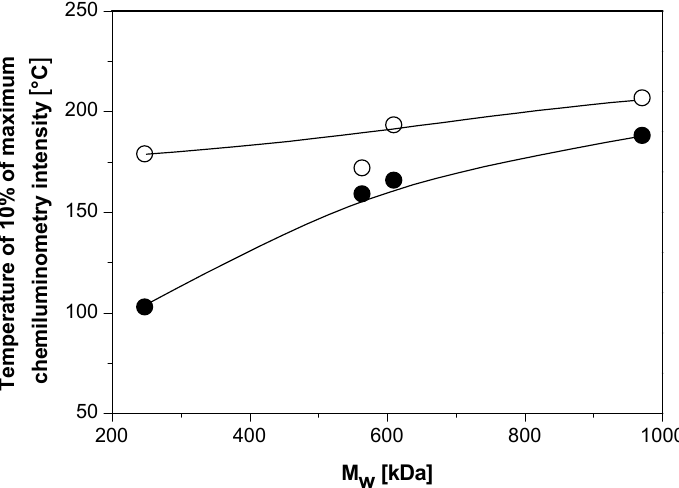
Figure 8. The plot of temperature of achieving 10% of the maximum chemiluminescence intensity expressed in relative units vs . molar mass M w . The sample treatments were carried out in oxygen ( ○ ) and nitrogen ( ●